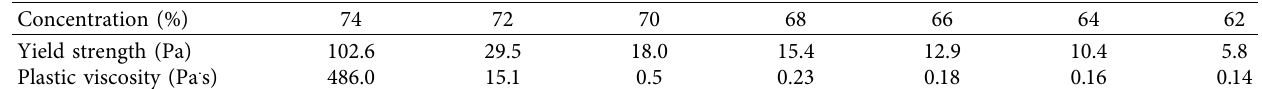
Figure 4: The slump-value-slurry-concentration curve. Table 4: Rheological parameters of slurry.